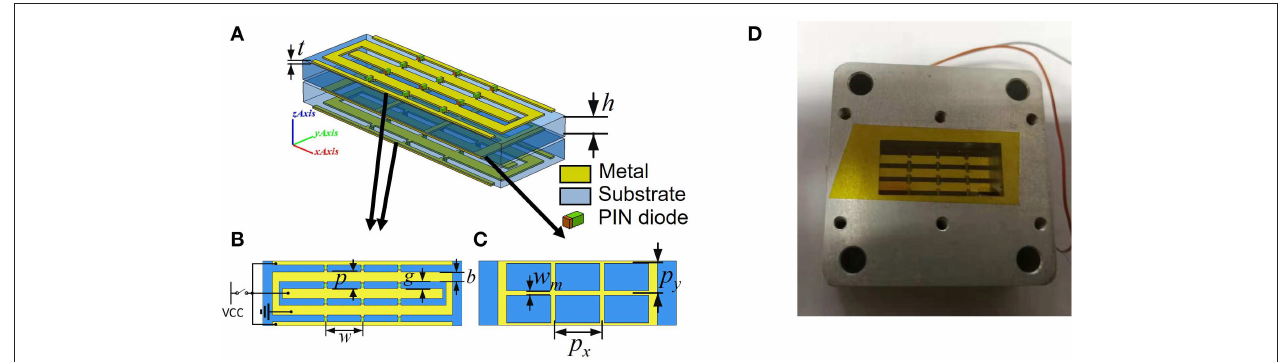
FIGURE 1 | (A) Schematic of the switchable metasurface with three metallic layers and two dielectric layers. Top views of (B) the upper layer and the bottom layer, (C) the middle layer. (D) The photo of our sample with the